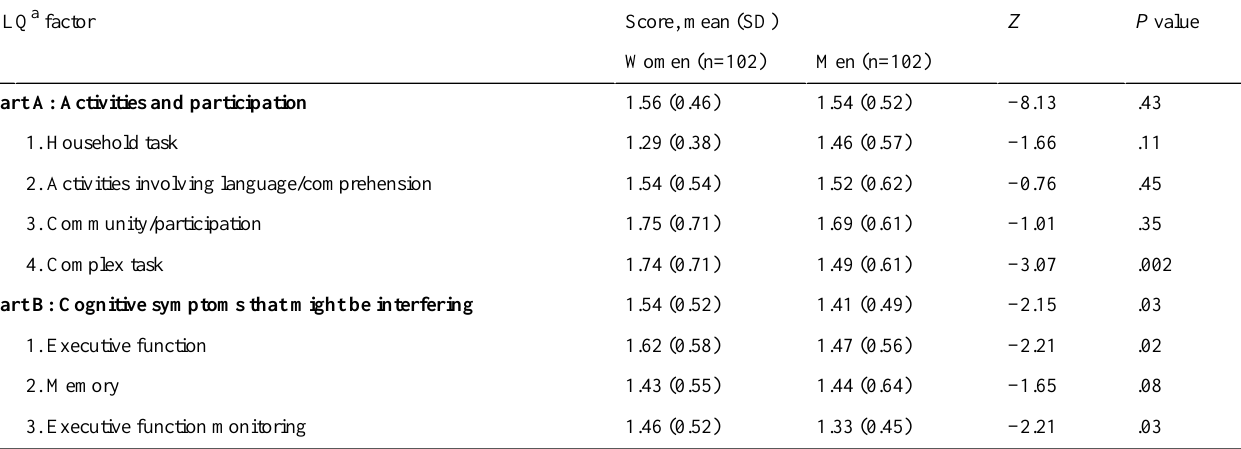
Table 3. Gender comparison of the mean scores and standard deviations of the DLQ